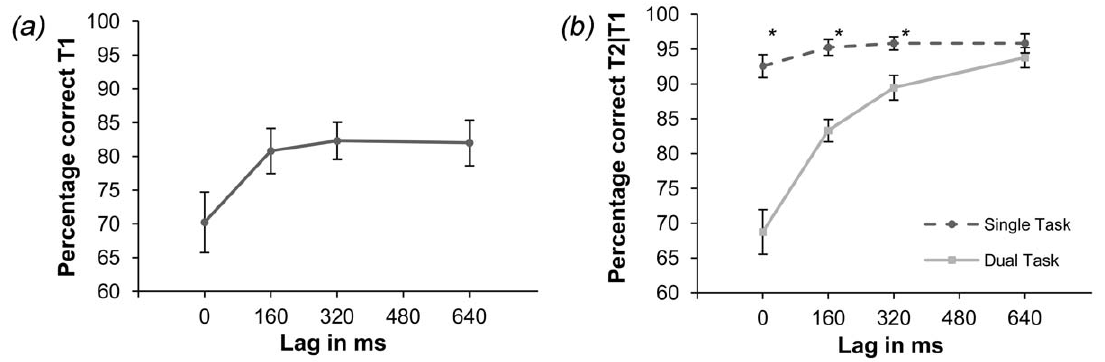
Figure 2. Results of Experiment 1. Panel (a) Percentage correctly identified letters in the dual-task condition. T1-identification in the dual-task condition was significantly lower for lag 0 ms than for all other lags. Panel (b) T2 detection performance in percentage correct in the single- and dual- task conditions. Dual-task results are based on trials with correctly identified letters. T2-detection in the dual-task condition is significantly lower for lags 0 ms, 160 ms and 320 ms than in the single-task condition. Stars mark significant differences between single- and dual-task condition per lag (p , 0.05). Note that in this figure chance level is 50%. Error bars reflect 95% confidence intervals in both panels.